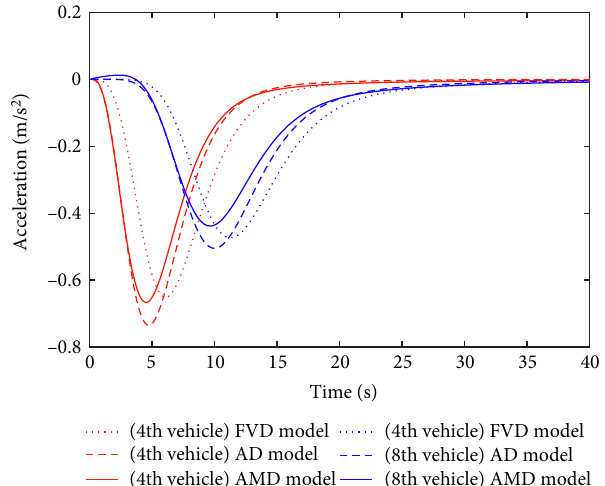
Figure 10: Acceleration evolutions of single vehicle during braking